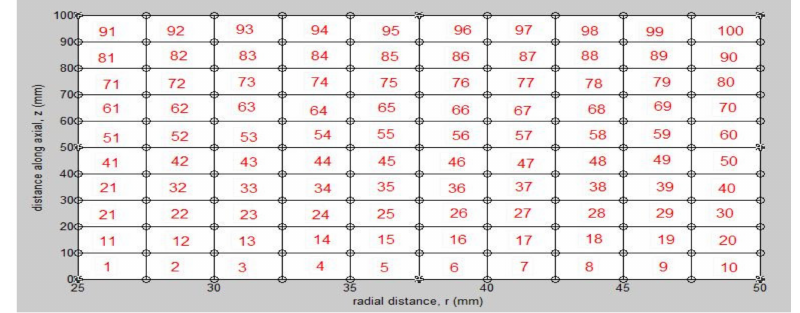
Figure 15. Finite element mesh for the geometry of an axisymmetric pipe